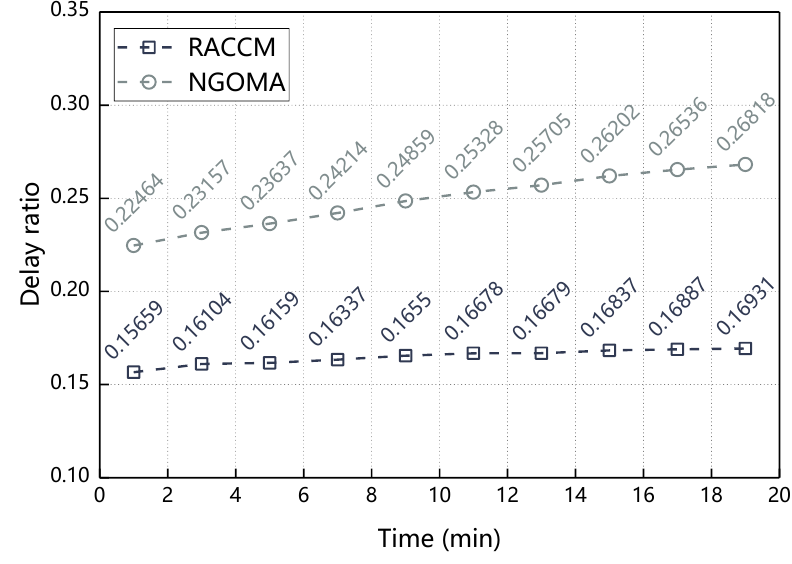
Figure 12. Delay ratio with respect to time.